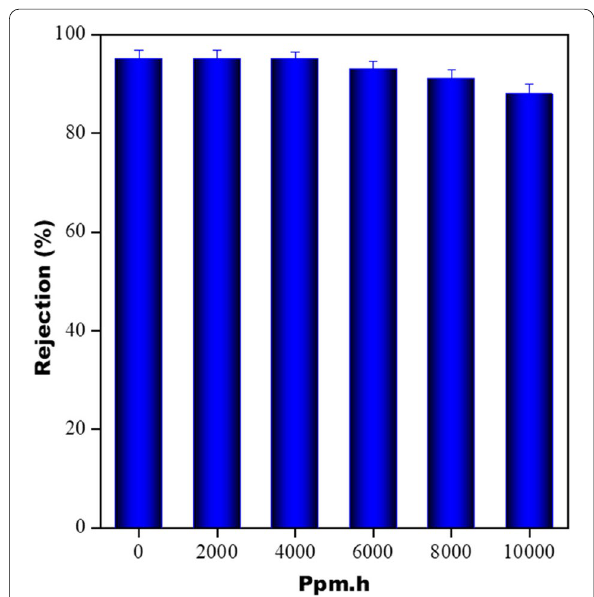
Fig. 11 Rejection performance (monovalent ion) of PSS-PDA-crosslinked membrane on chlorine exposure